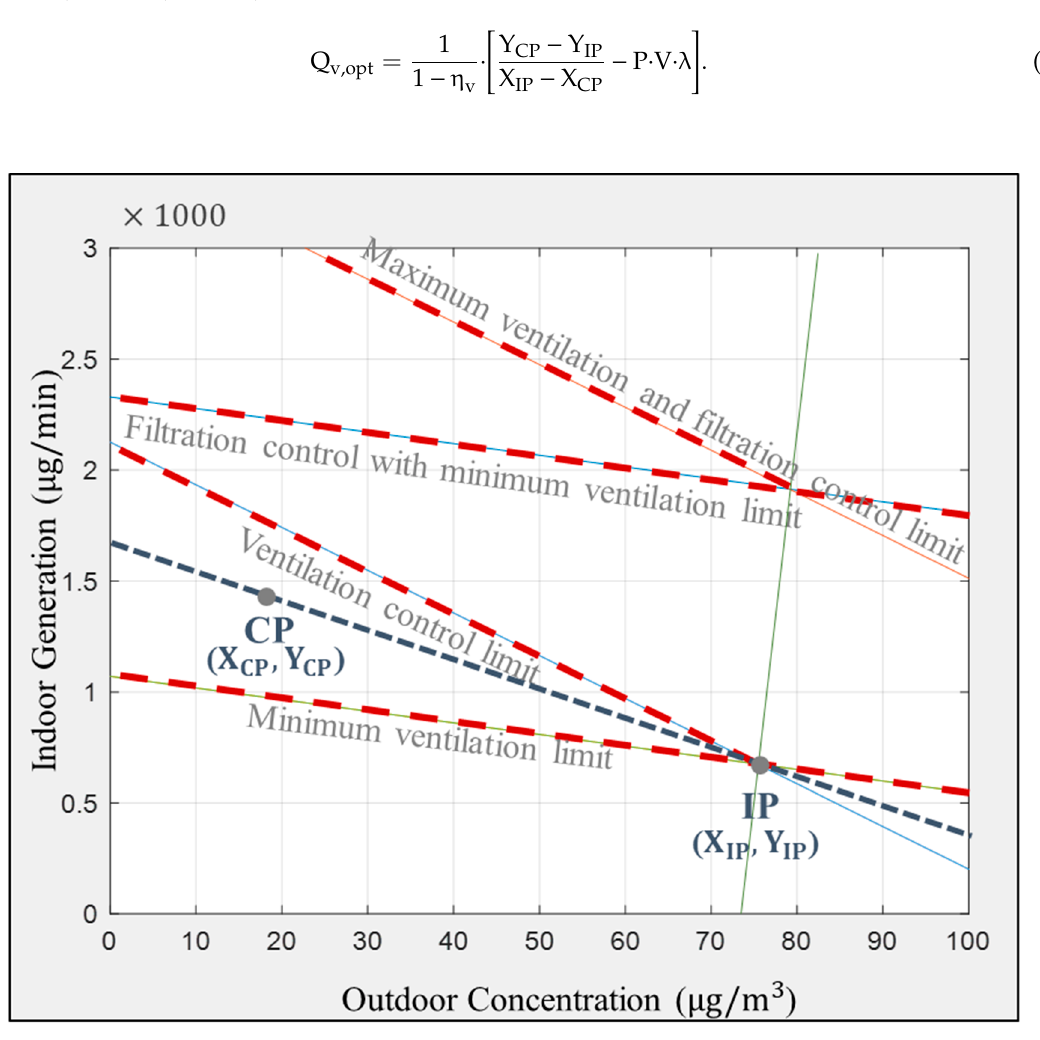
Figure 8. A linear graph passing through the CP and the intersection point (IP) simultaneously for estimating Q v,opt The optimum filtration rate ( Q (cid:2916),(cid:2925)(cid:2926)(cid:2930) ) to maintain the indoor target concentration can be obtained